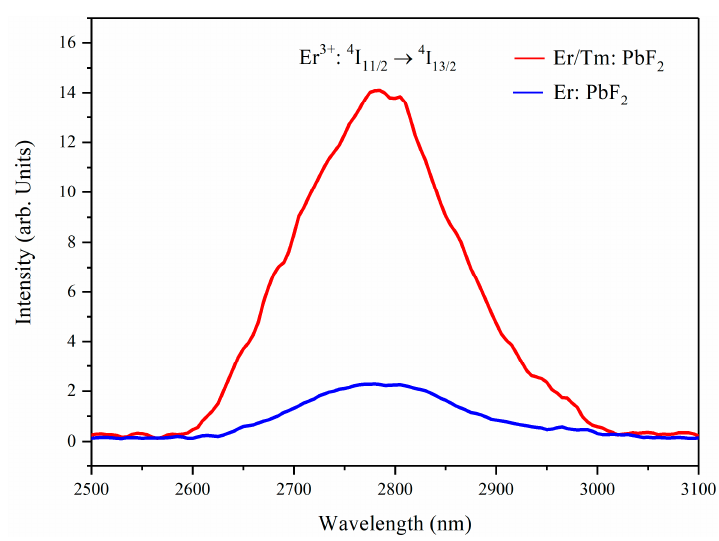
Figure 6. Emission spectra of the Er: PbF 2 , Er/Tm: PbF 2 crystals in the range of 2500–3100 nm ( λ ex = 800 nm).